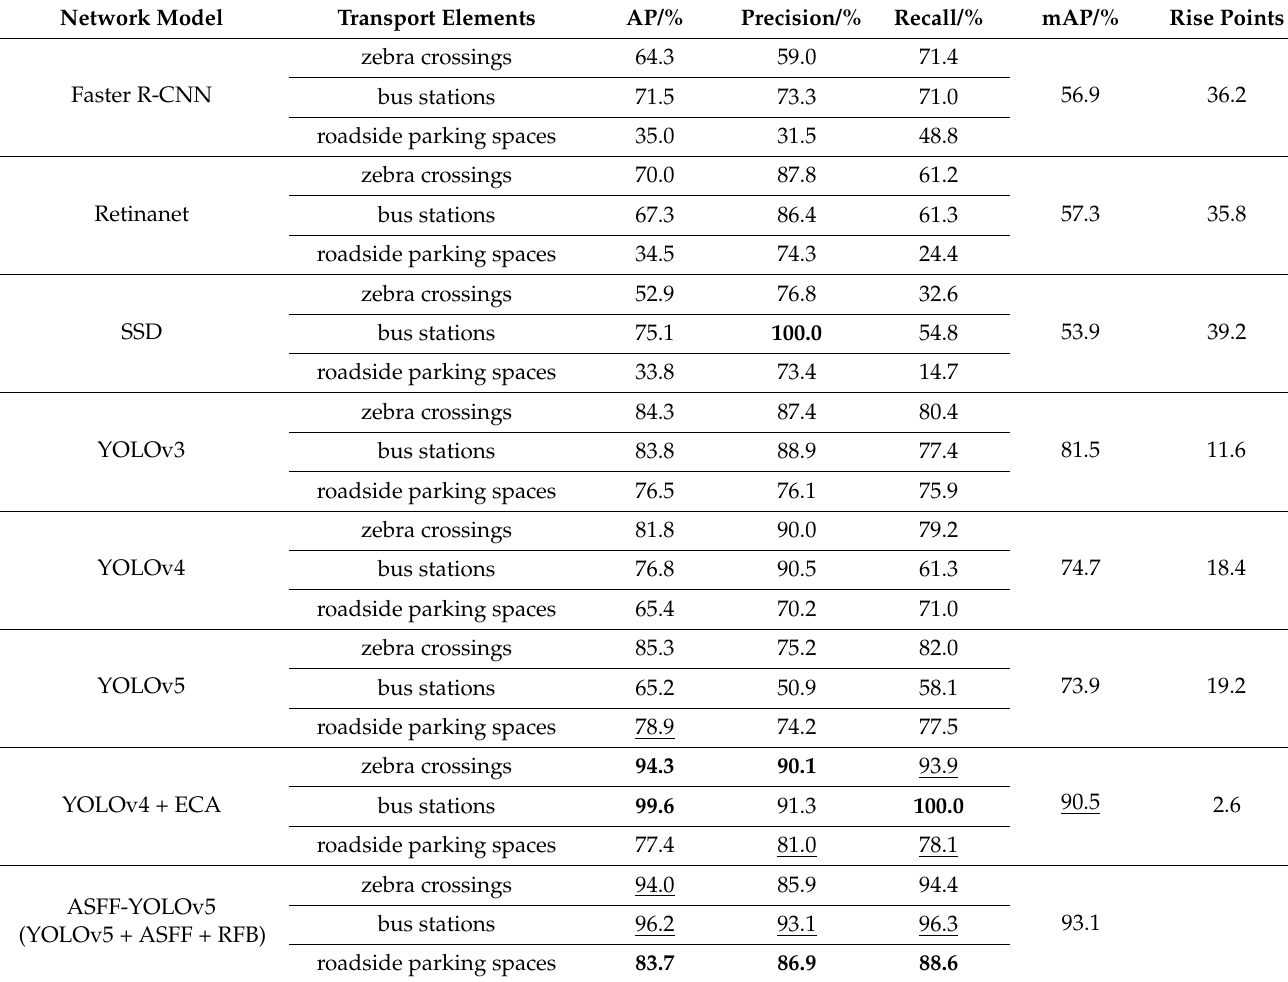
Table 3. Detection results of different networks.